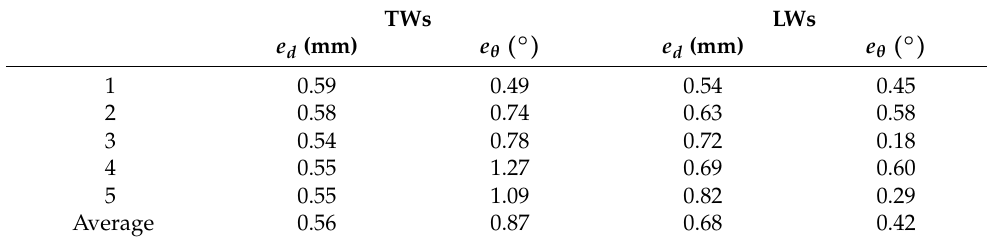
Table 2. Results of the experiments on validation of US probe calibration.